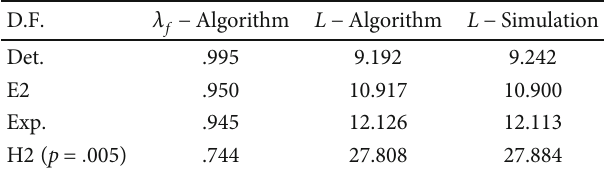
Table 3: The model with M = 100 , N = 80 , Y = 20 , and ρ = 0 : 012